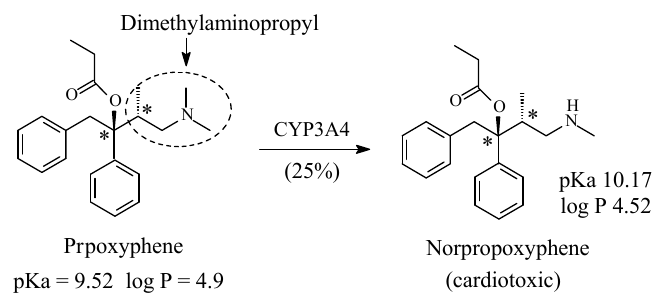
Figure 27. Major metabolic pathway of dextropropoxyphene.